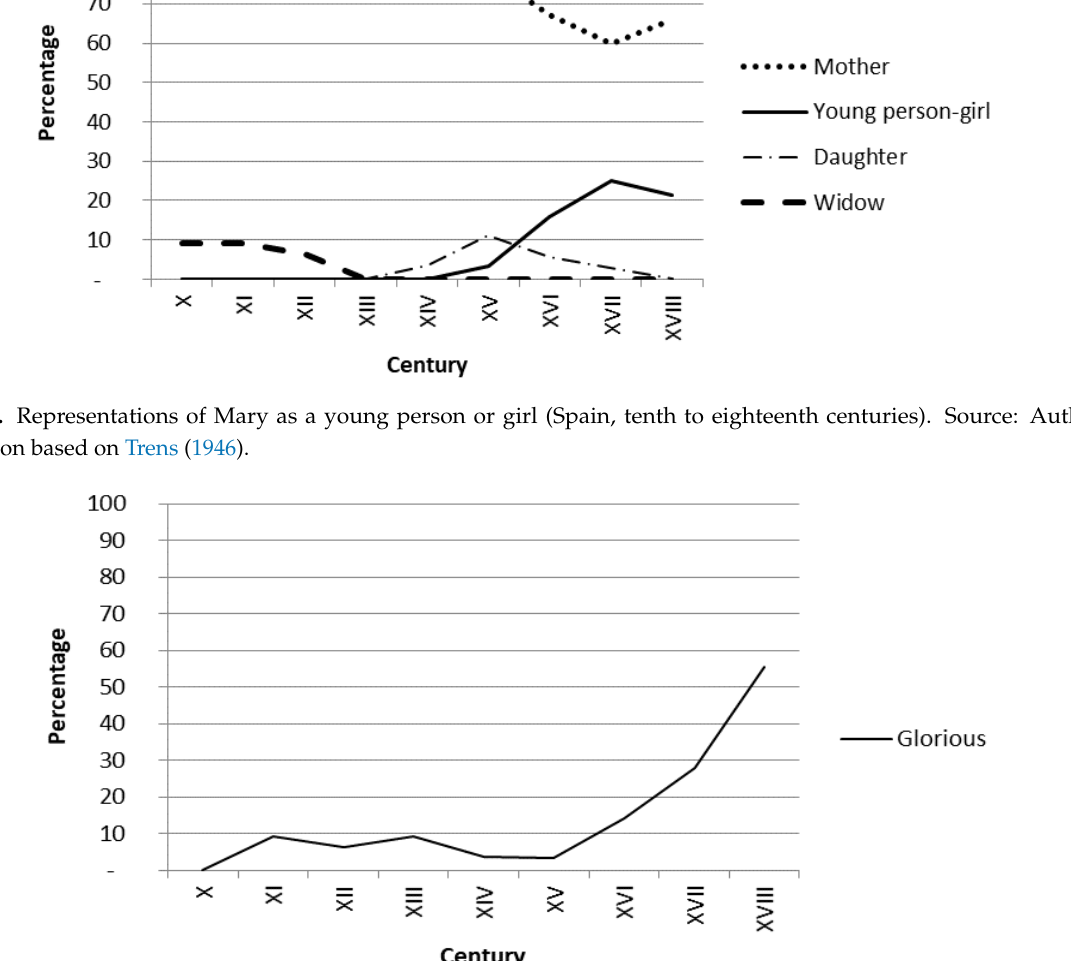
Figure 6. Presentations of Mary’s posture (Spain, tenth to eighteenth centuries). Source: Authors’ elaboration based on Trens (1946). Mary mostly appears in two positions, namely sitting (46%) and standing (43%). 6 However, her position varies greatly over time. Starting in the first centuries until the fif- teenth century, Mary appears mostly seated. However, after a peak in the thirteenth cen- tury, representations of Mary seated tend to decline in favor of standing. In the sixteenth century, both representations were balanced, while standing began to dominate starting